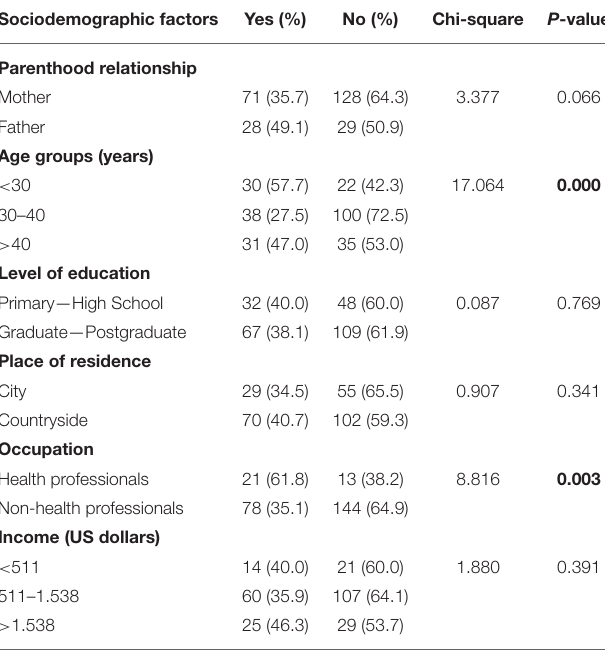
TABLE 2 | Responses of parents regarding whether children are more resistant to COVID-19.